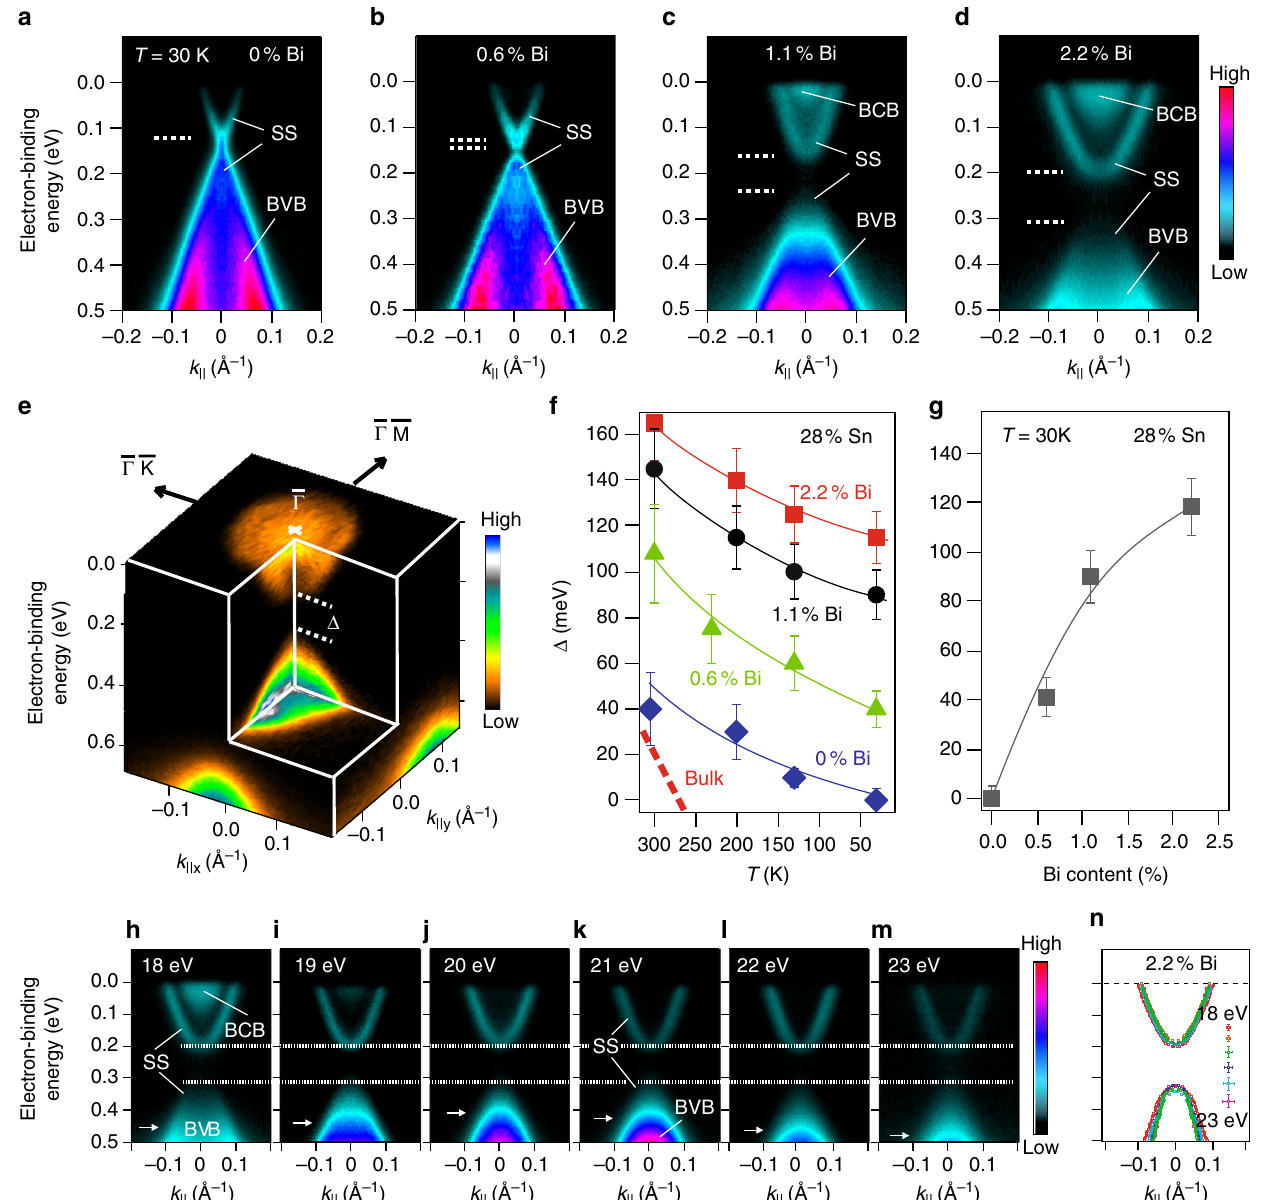
Fig. 2 Doping effect and gap opening at Γ induced by Bi. Incorporation of Bi in Pb 0.72 Sn 0.28 Se (111) fi lms leads to n -type doping and a gap opening at the Γ point as revealed by ARPES. a – d ARPES data measured at a temperature of 30 K and 18 eV photon energy. e Corresponding full ARPES map around the Γ point for n Bi = 2.2%. f , g Dependence of the surface band gap Δ on temperature and n Bi . The error bars correspond to the uncertainty in determining the energy position of the band dispersions at the Γ -point (Supplementary Note 6). h – m Photon energy dependence for n Bi = 2.2%, indicating that the gapped surface state (SS) is two-dimensional. At high binding energies, the dispersion of the bulk-valence band (BVB) with photon energy (marked with horizontal white arrows) can be distinguished from the lower half of the SS. The dispersion of the bulk-conduction band (BCB) can be observed between 18 and 20 eV, while the size of the surface gap remains qualitatively unchanged as indicated by horizontal dashed lines. n Energy-momentum dispersions of the upper and lower part of the SS as extracted from fi ts to results shown in h – m (see Supplementary Fig. 8 and Supplementary Note 7 for details). The error bars given in the legend represent the maximum uncertainty in determining the corresponding band